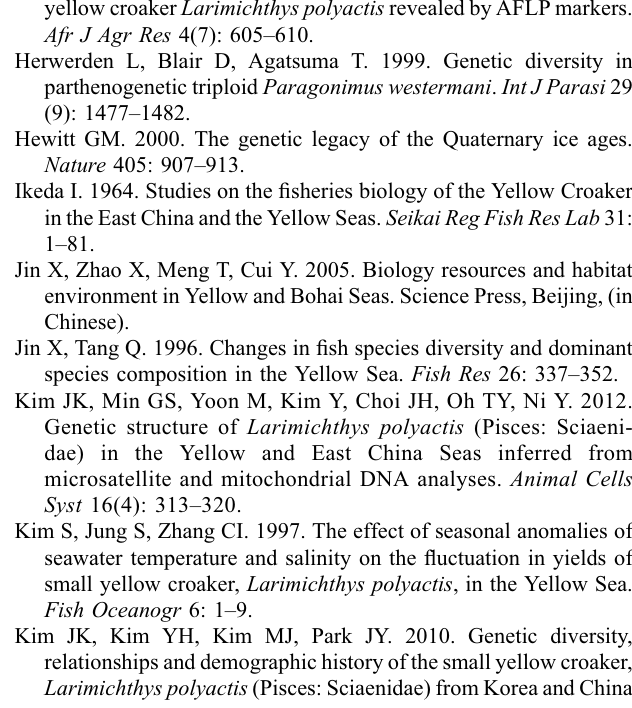
Fig. S1. Allele frequencies at two selected microsatellite loci (XHY8 and XHY25) for the fi ve populations: DG, LYG, SC, TZ, YT. The X axis shows allele sizes, while frequencies are indicated on the Y axis. Fig. S2. Unweighted Pair-group Method with Arithmetic Means tree (UPGMA) among 5 populations of Larimichthys polyactis constructed with the Nei ’ s genetic distances. Table S1. Statistics for genetic variation at 20 microsatellite loci in fi ve populations of Larimichthys polyactis collected from the Yellow Sea and East China Sea. Table S2. P-values of bottleneck tests for detecting the recent population declines of Larimichthys polyactis using two phased mutation model (TPM), stepwise mutation model (SMM) and mode shift